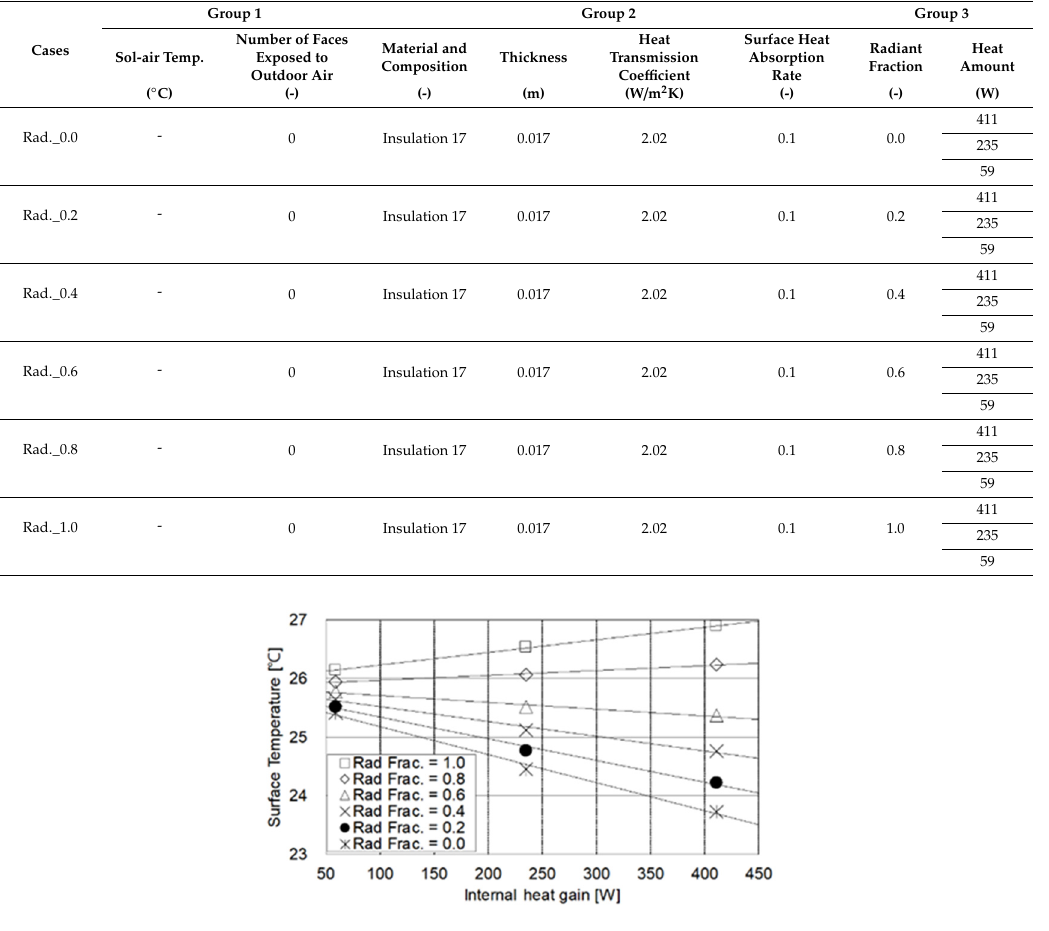
Table 15. Cases for component of internal heat gain (unexposed to outdoor air).